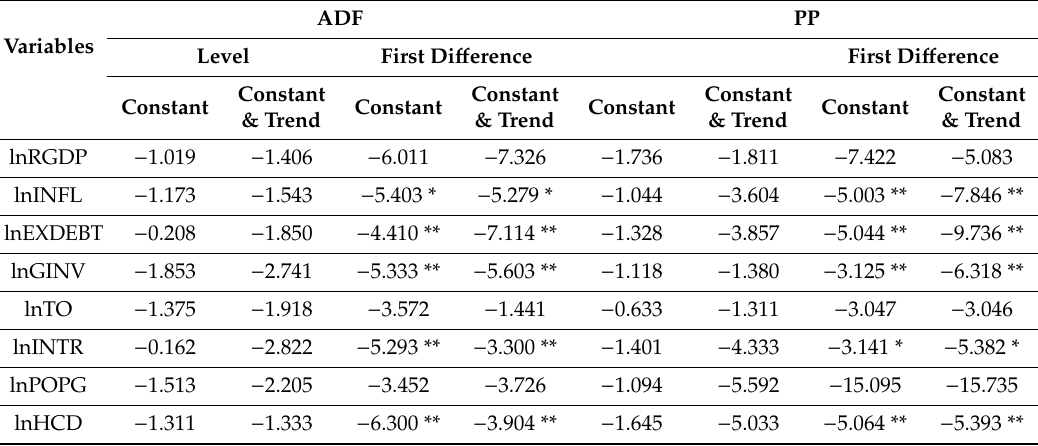
Table 4. Results of unit root analysis.